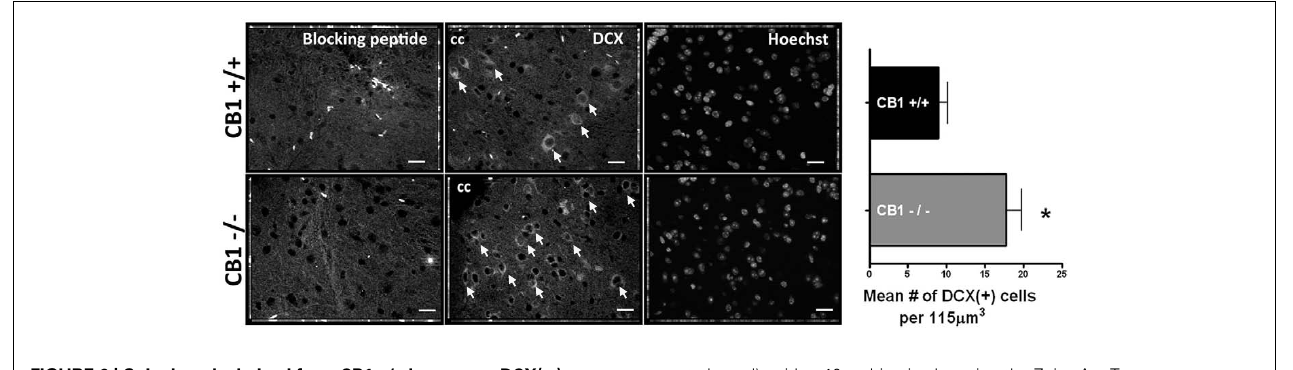
FIGURE 6 | Spinal cords derived from CB1 − / − have more DCX( + ) cells compared to those derived form CB + / + animals. Spinal cord sections (6 μ m thick) were treated with anti-DCX in the presence (first panels) or absence (middle panels) of the blocking peptide.The third panels show Hoechst nuclear staining for the middle images. Images were acquired in the medial region of the spinal cord (next to the